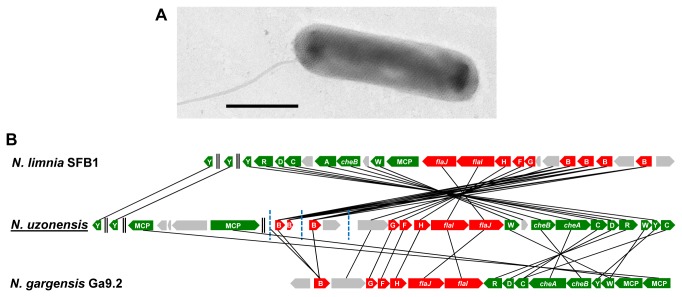
Findings supporting flagellation of “Ca. Nitrosotenuis uzonensis”(A) Intact cell stained with uranyl acetate, showing a subpolar tail-like cell projection, possibly a flagellum, and a network of hexagonal structures on the cell surface. (B) Organization of flagellar- and chemotaxis-associated genes in its genome. Genes encoding parts of the archaeal flagellum (fla genes) and chemotaxis apparatus (che genes) are given in red and green, respectively, whereas other genes are shown in grey. For details on these genes please refer to Table S8 in File S1. Black double bars indicate separate genomic regions, while blue bars display contig ends. MCP, putative methyl-accepting chemotaxis protein.